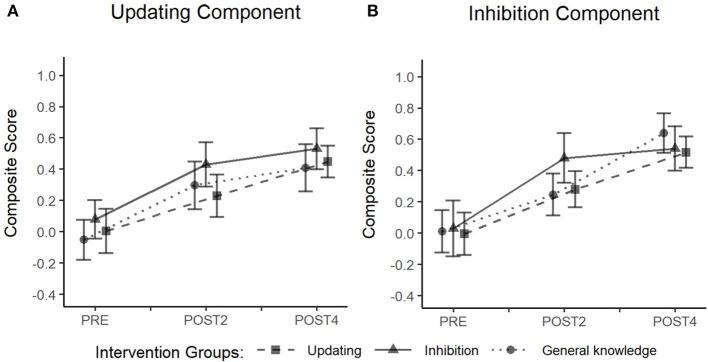
Performance growth on proximal transfer outcomes as a function of time and training group. Composite scores correspond to the averaged z scores of the antisaccade and Victoria Stroop tasks for the inhibition composite score (A), and the averaged z scores of the keep track and running span tasks for the updating composite score (B).